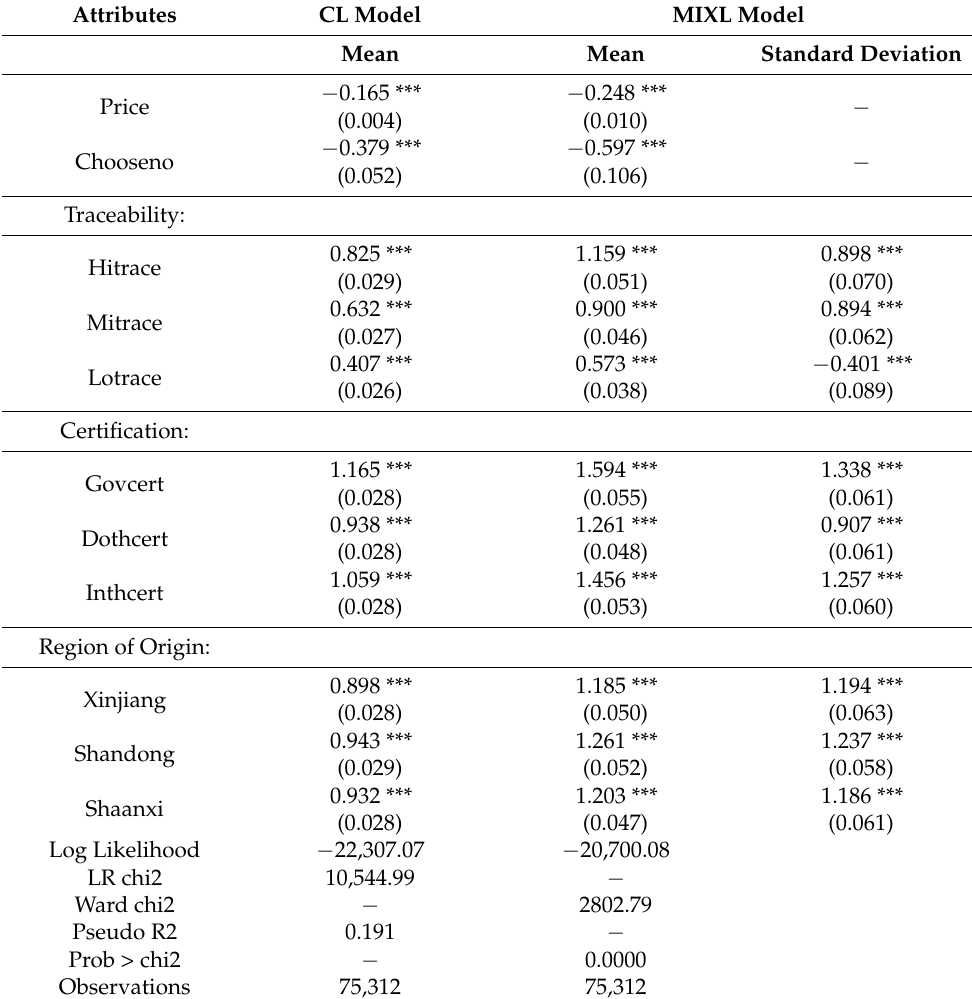
Table 4. Estimates from Conditional Logit model (CL model) and Mixed Logit model (MIXL